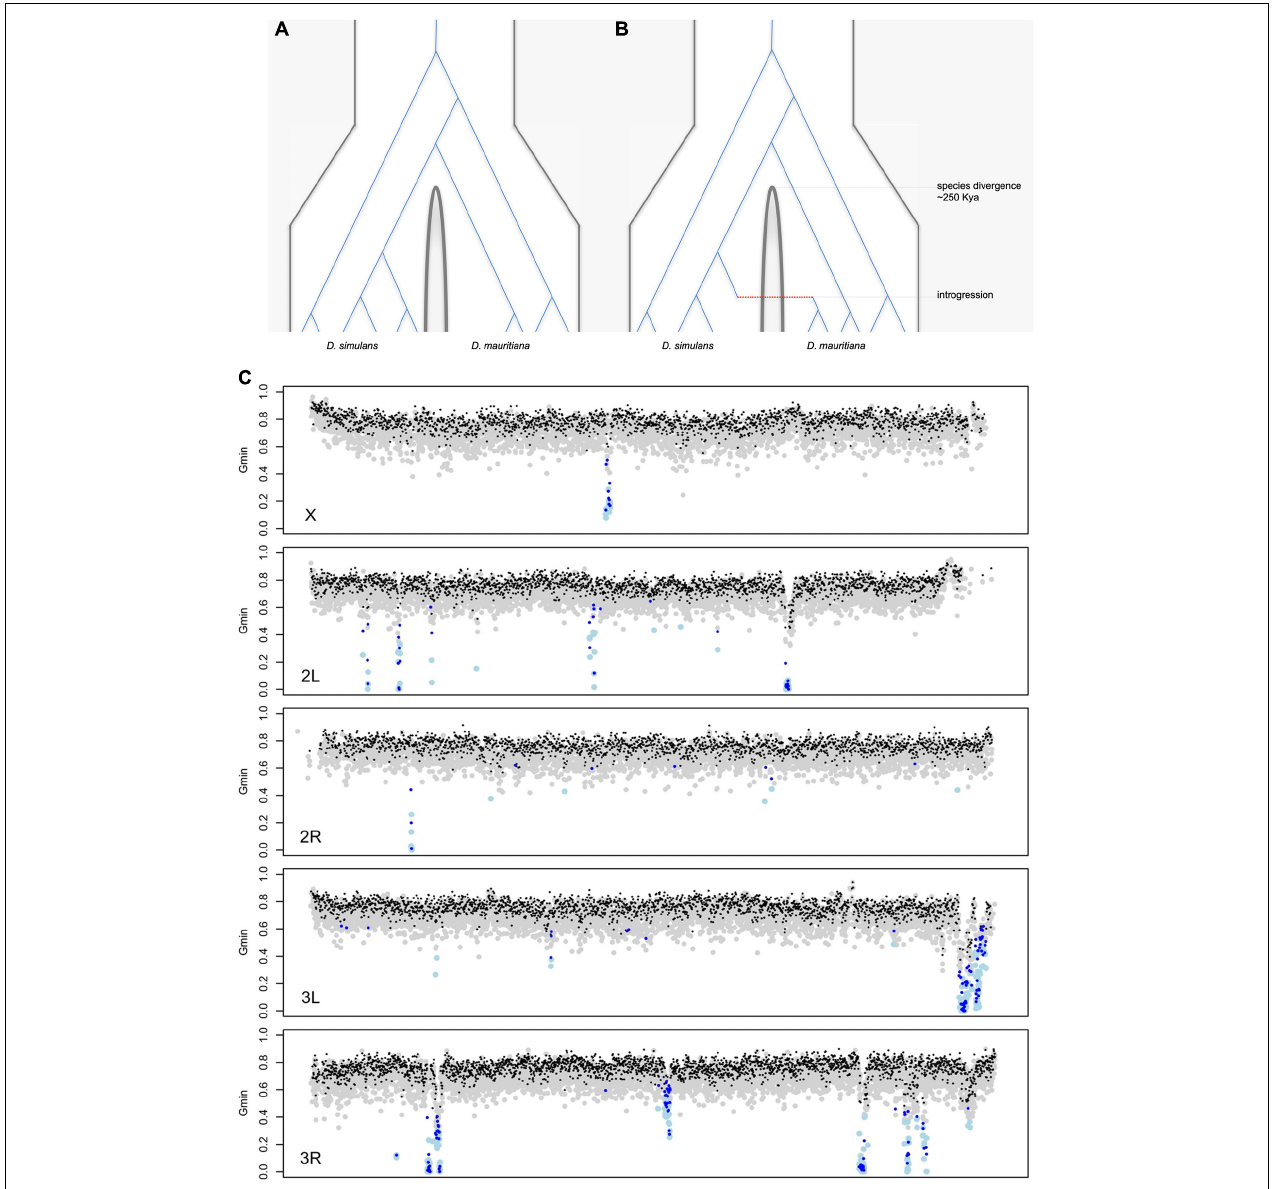
FIGURE 6 | Hypothetical genealogical histories of multiple sequences sampled from two species under (A) simple allopatric speciation with no gene flow and (B) complex speciation with gene flow. Under simple allopatric speciation, all coalescent events among any two gene copies from the different species must predate the species divergence time. Under complex speciation, coalescent events between any two gene copies from the different species can postdate the species divergence time, as represented by the single introgression event (red). (C) A genome-wide scan for introgression in population samples from D. simulans ( n = 20) and D. mauritiana ( n = 10). The G min statistic was used to identify haplotypes with interspecific distances too low to be consistent with a simple allopatric speciation history (Geneva et al., 2016). Each gray (black) dot corresponds to a 5-kb (10-kb) genomic window consistent with a simple allopatric history, and each light blue (dark blue) dot corresponds to a 5-kb (10-kb) genomic window for which the simple null model is statistically rejected. Introgression is significantly underrepresented on the X chromosome (Meiklejohn et al.,